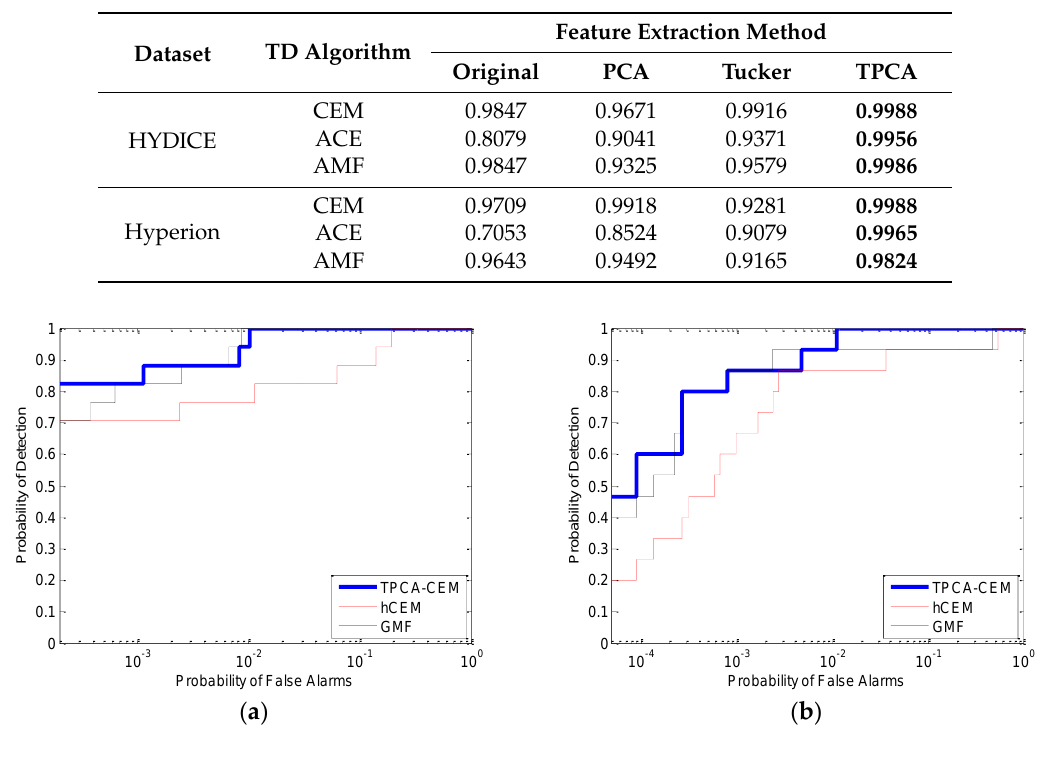
Figure 16. ROC curves with different target detection methods for the real data: ( a ) HYDICE; and ( b ) Hyperion. Table 7. AUCs and running time for the TD of real datasets with different TD algorithms.